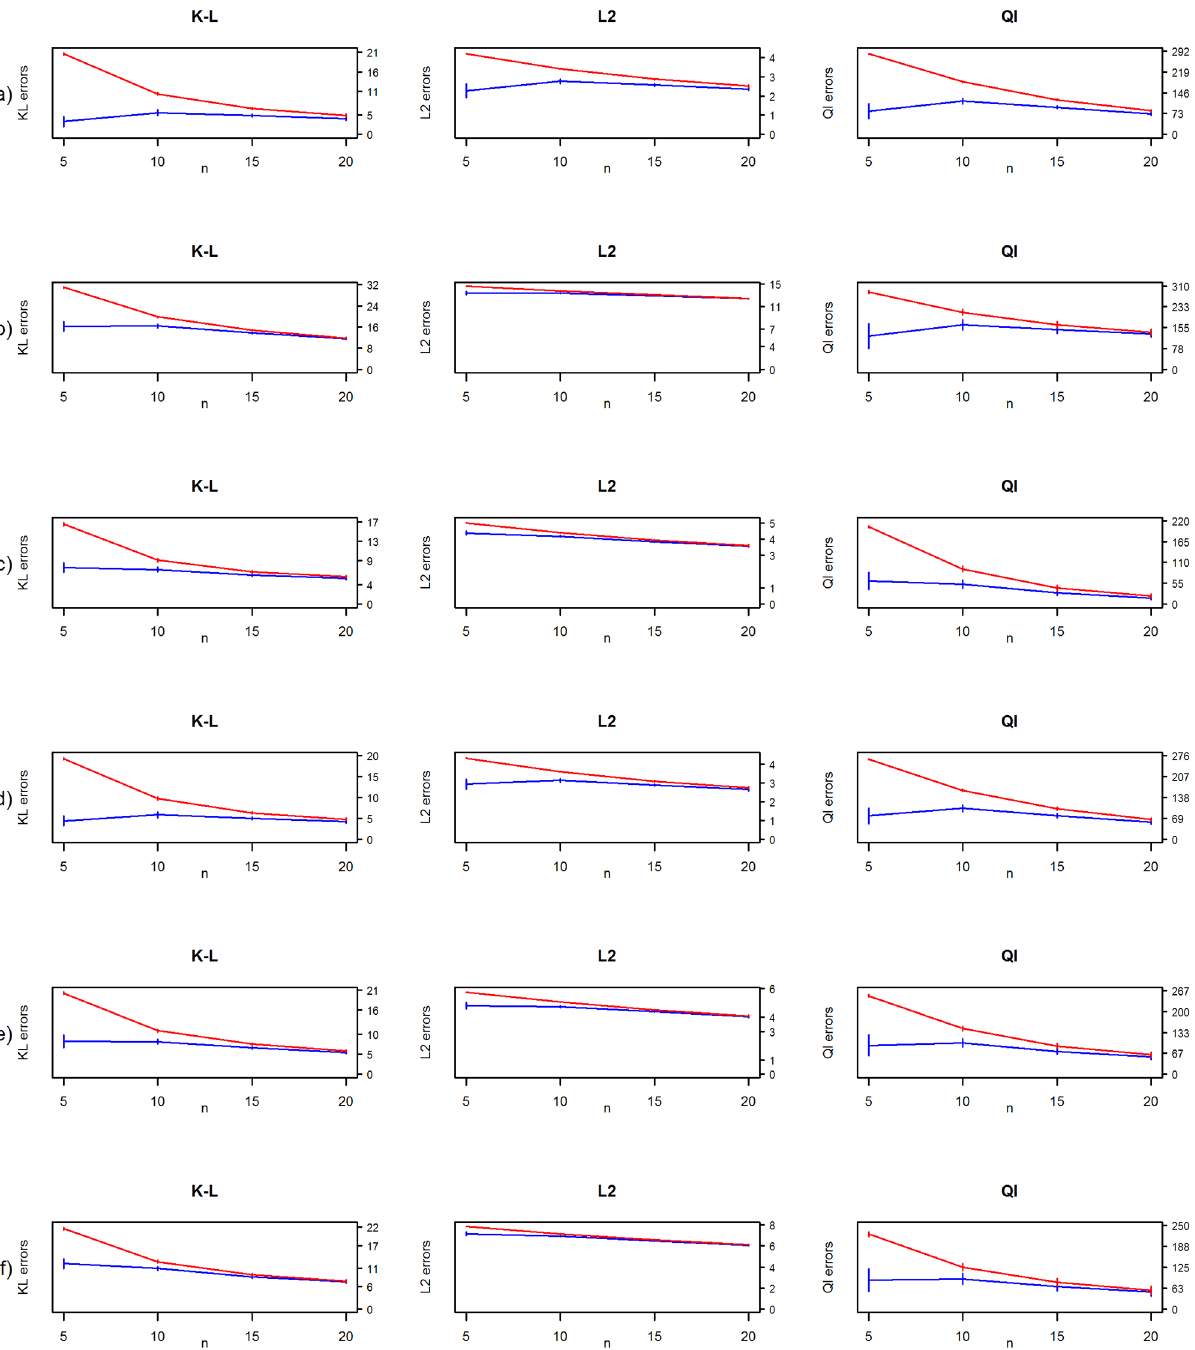
Fig 6. Frequentist risk estimates from the simulation studies. Kullback-Leibler (K-L), L2-loss (L2) and quadratic losses (Ql) for (a) diagonal, (b) AR(1), (c) AR(2), (d) sparse, (e) moderate and (f) dense precision matrices for diminished condition number (blue line) and common Wishart prior based MAP (red line) with r and α set as p